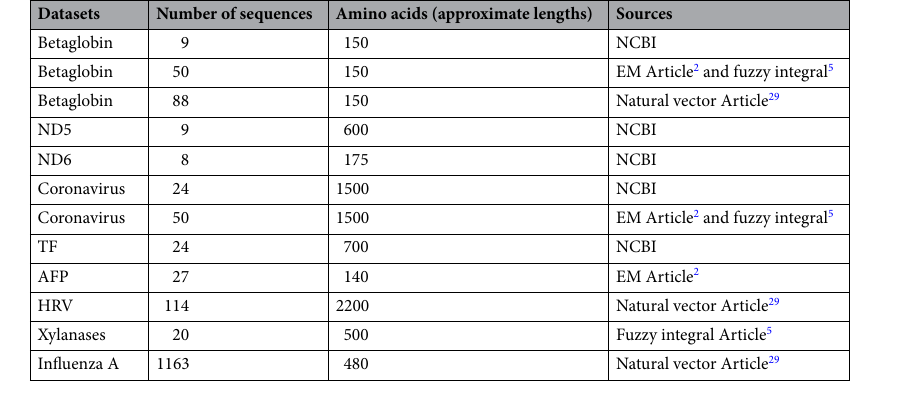
Table 2. Benchmark datasets